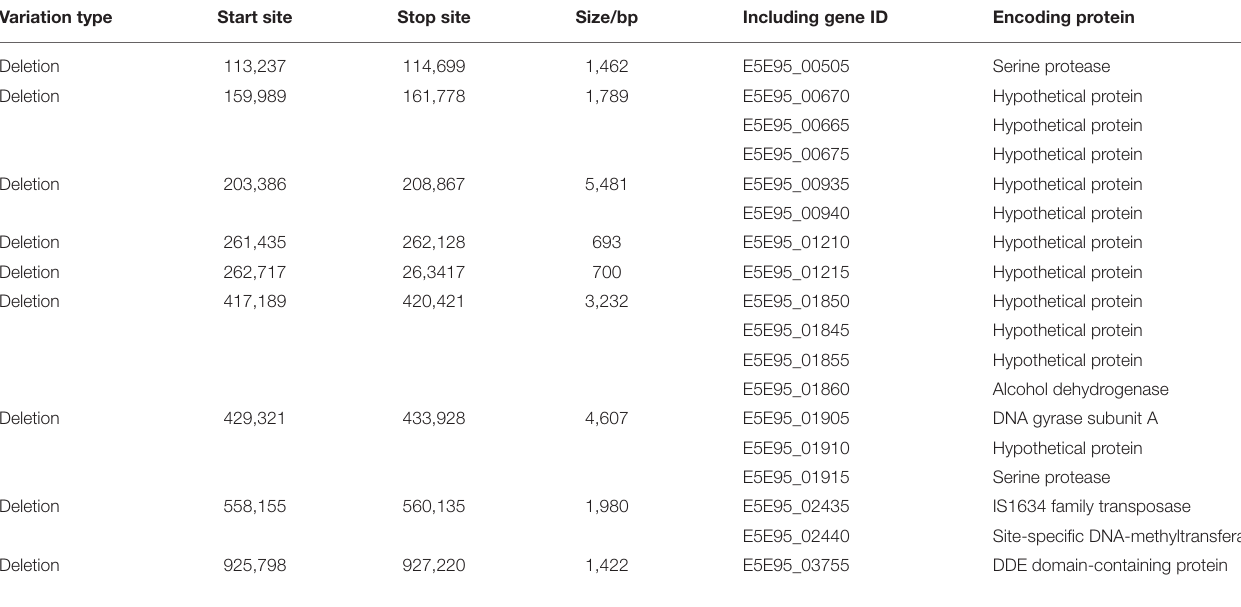
TABLE 1 | Eighteen genes in regions deleted from the genome of strain ES-2L. Variation